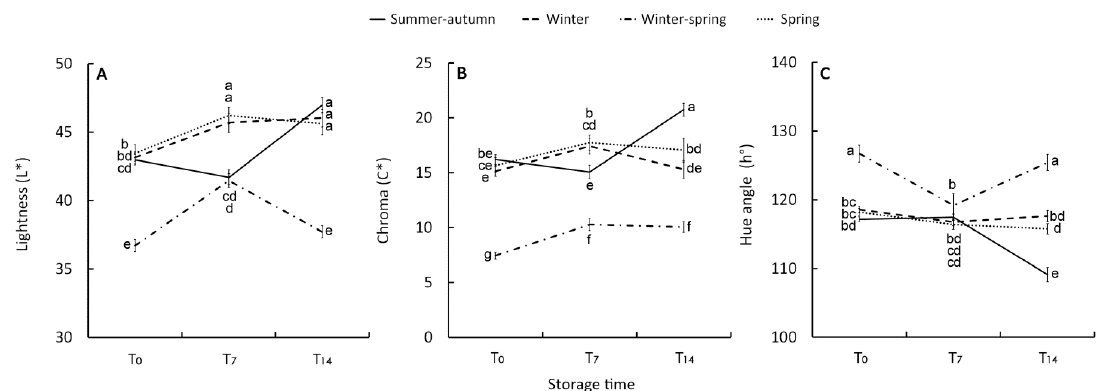
Figure 3 . Effect of growing cycle on lightness (L*) ( A ), chroma (C*) ( B ), and hue angle (h°) ( C ) index of the raw heads (T 0 ), 7 days (T 7 ) and 14 days (T 14 ) stored product. Vertical bars (± SE of mean) ( n = 9) with different letters are significantly different according to the Least Significant Difference test ( P = 0.05).